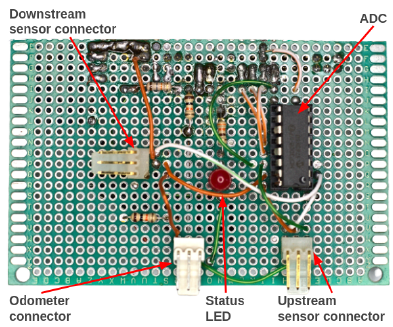
Figure 20. Top view of the Pi Add-On Board. An analog-to-digital converter (ADC) was used to interface the pressure sensors with the Raspberry Pi.